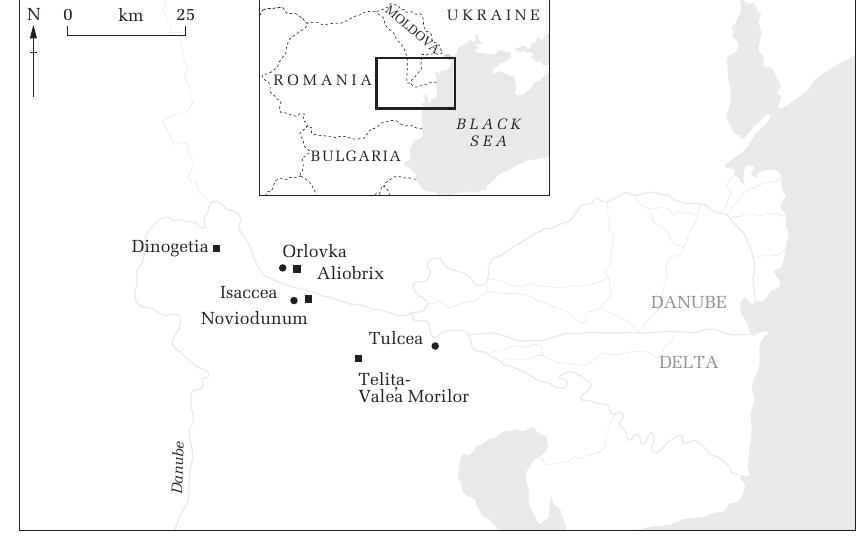
Figure 1 Southeastern Romania, showing the location of Noviodunum and other sites mentioned in the text.